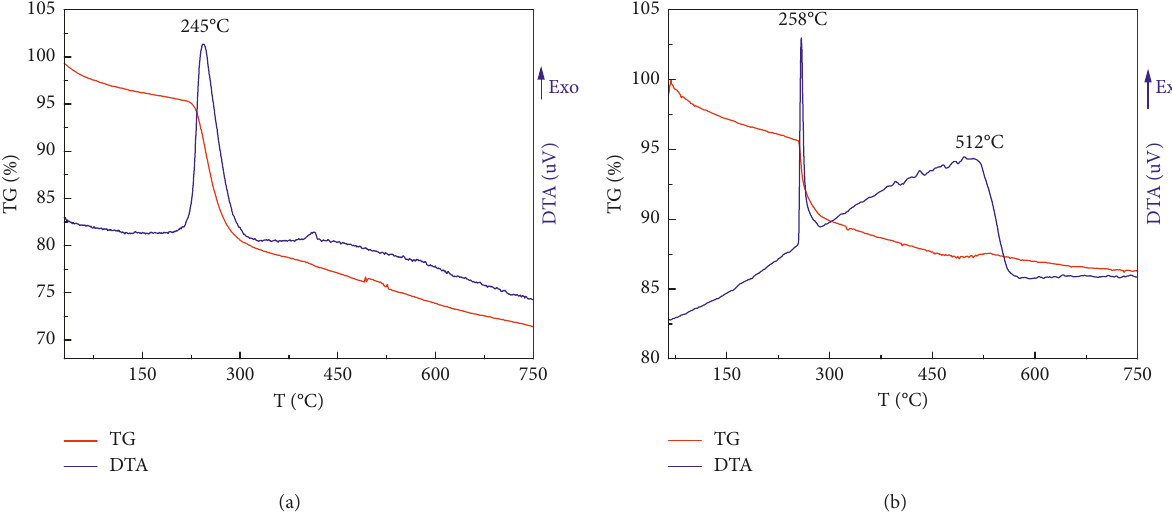
Figure 5: TG-DTA curves of SiO 2 aerogel (a) and TiN@SiO 2 composite aerogels